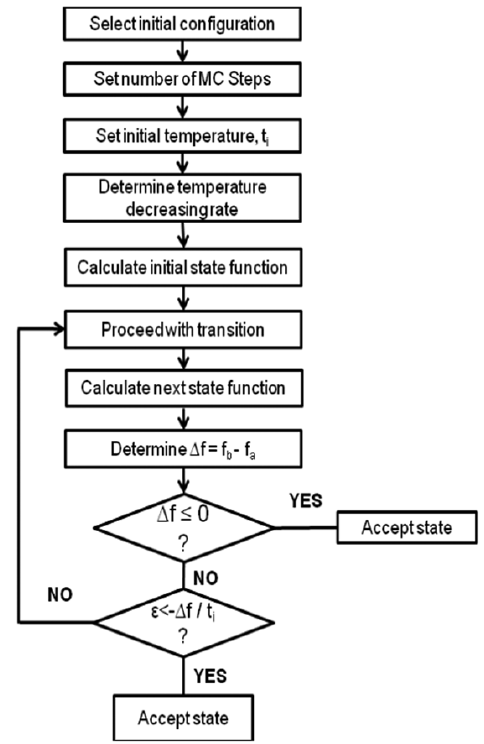
Fig. 2. Procedure for rule of accepting a function